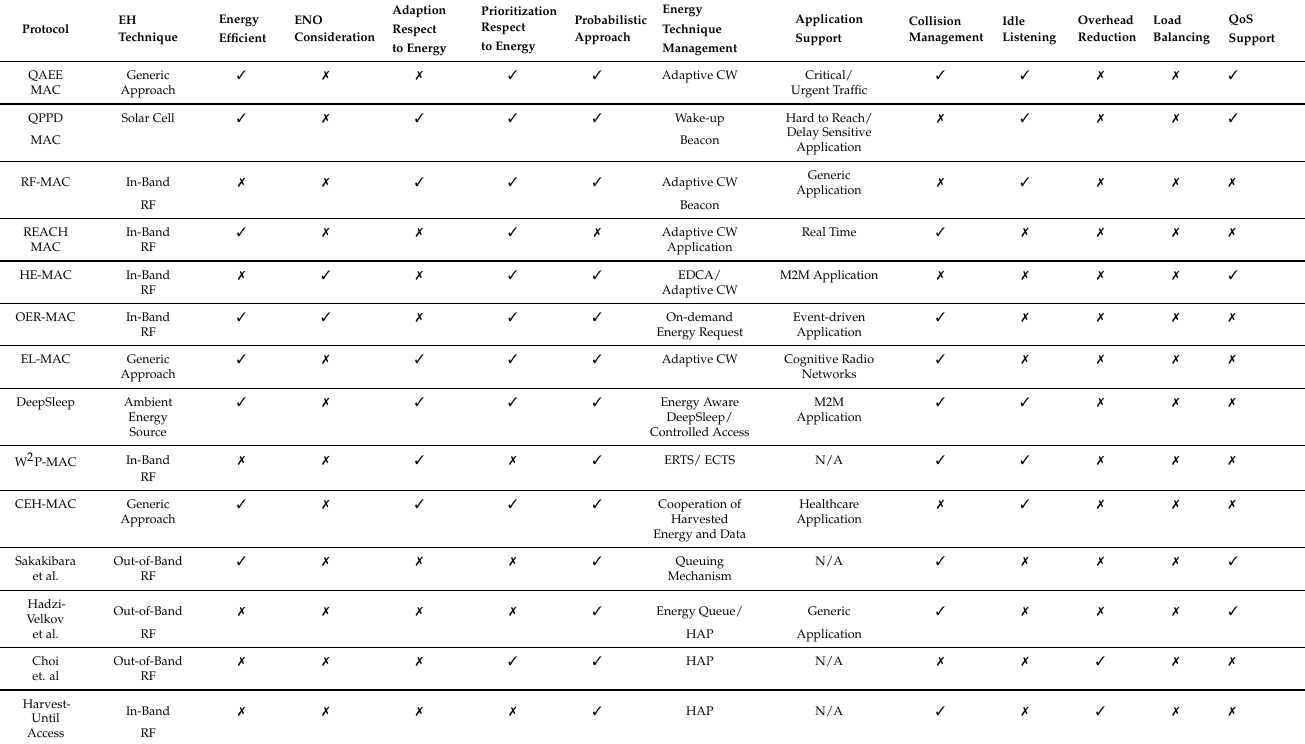
Table 7. Comparison of random access energy harvesting MAC protocols.